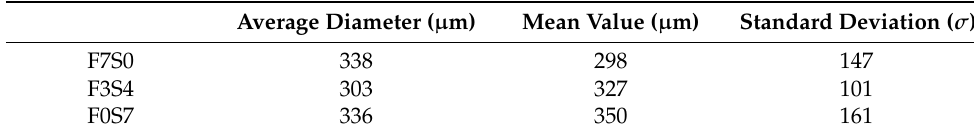
Figure 8. SEM images of the LCFLS at 2000× magnification.